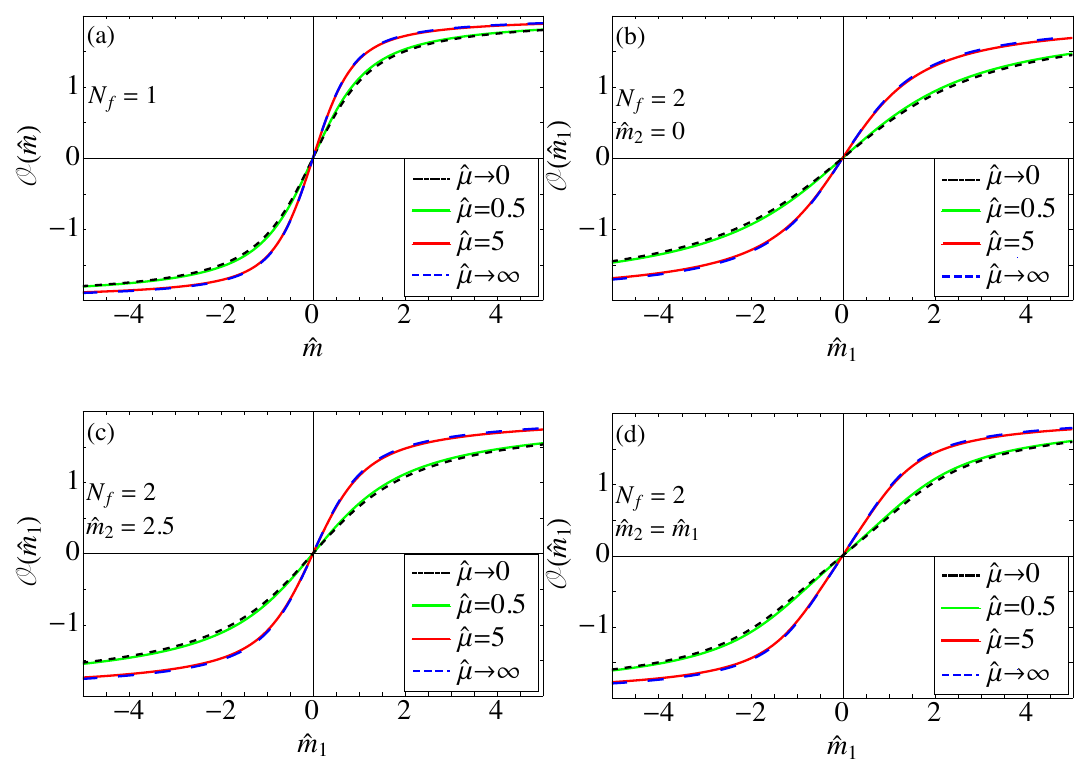
Figure 4 . The quantity O ( N f ) ( m 1 ) for the one-(cid:13)avour theory (plot (a)) and for the two-(cid:13)avour b theory as a function of the (cid:12)rst quark mass, while the second quark mass is (cid:12)xed at (b)), m 2 = 2 : 5 (plot (c)), and m 2 = m 1 (plot (d)). The solid red and green curves are given by b b b the analytical results (5.8) ( N f = 1) and (5.9) ( N f = 2) whilst the black and blue dashed curves are given by the limits (cid:22) ! 0 and (cid:22) ! 1 , respectively. We have employed the values b b